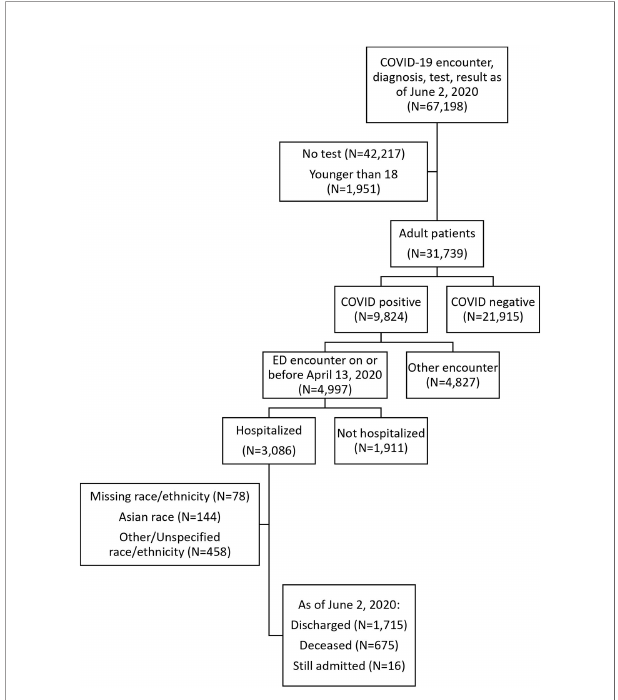
FIGURE 1 | Flow diagram of included